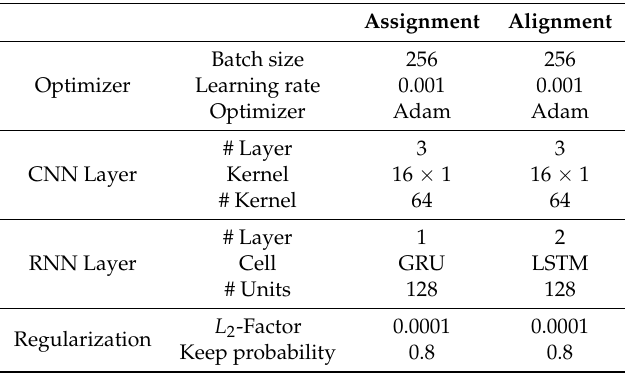
Table A1. Hyper parameters of the proposed network configurations, determined through cross validation based on dataset A and used for all tests.